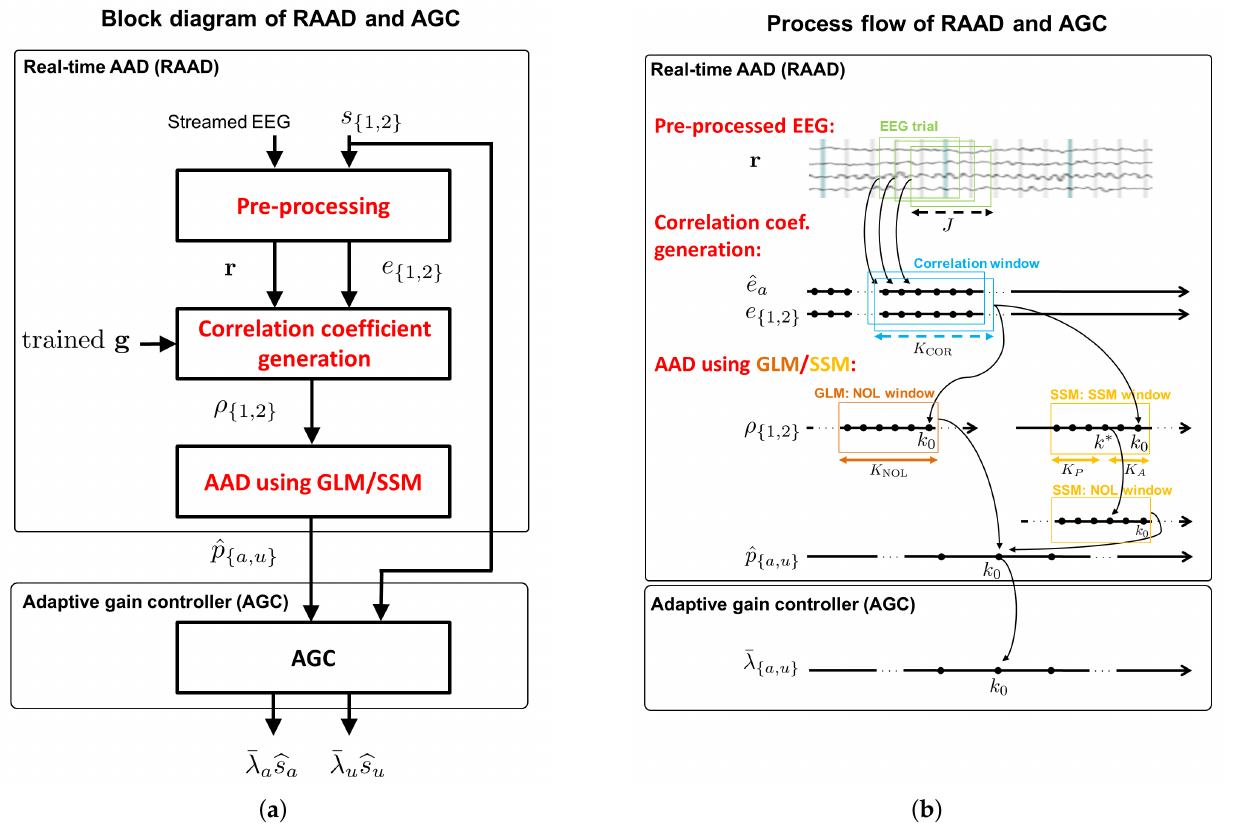
Figure 4. Real-time AAD (RAAD) and adaptive gain controller (AGC): ( a ) block diagram and ( b ) process